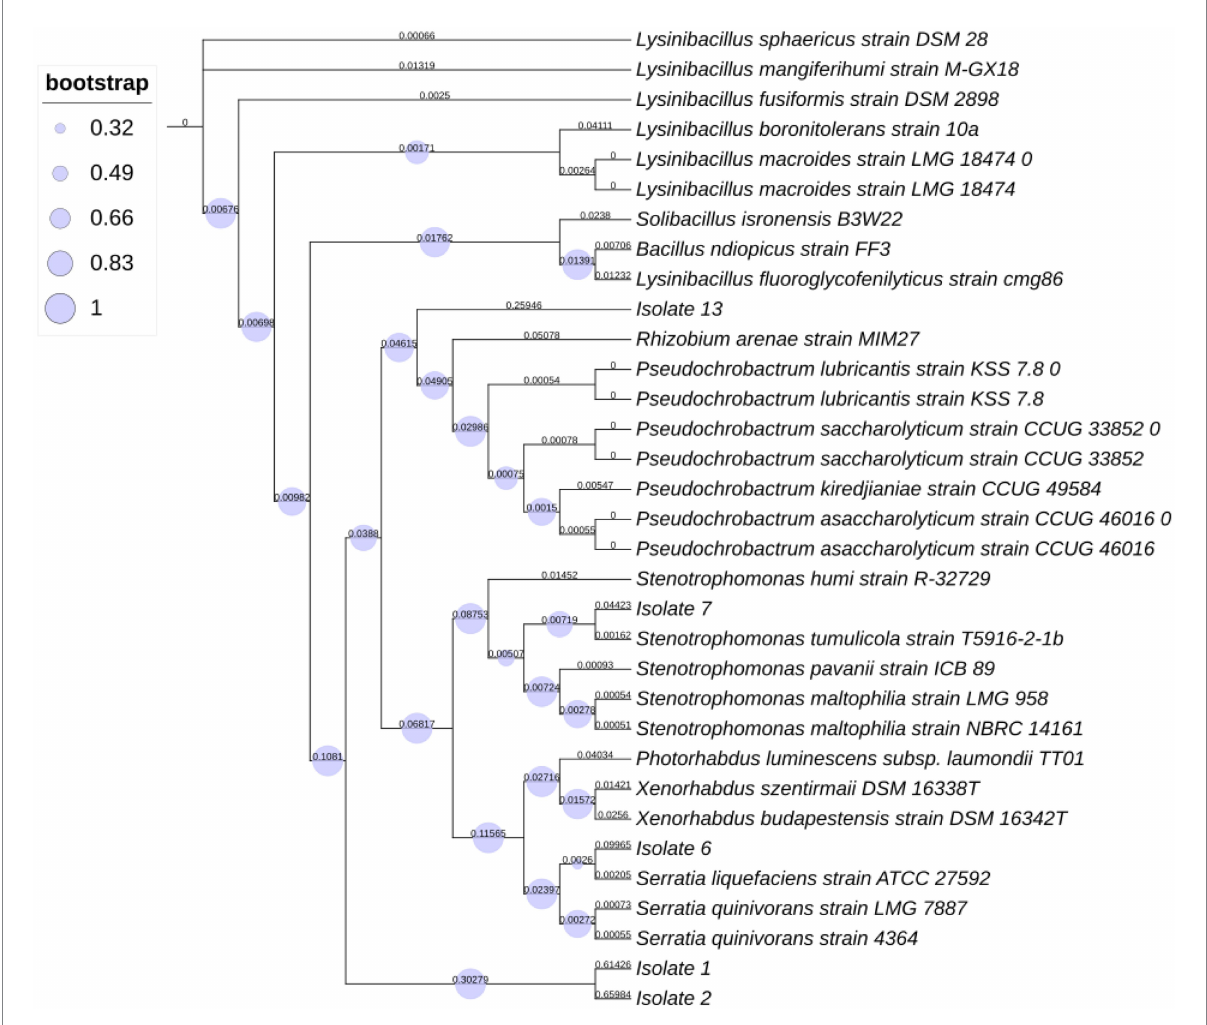
FIGURE 1 Phylogenetic tree represents distances based on the 16S rRNA sequences acquired from isolates within insect pathogenic nematodes Steinernema feltiae